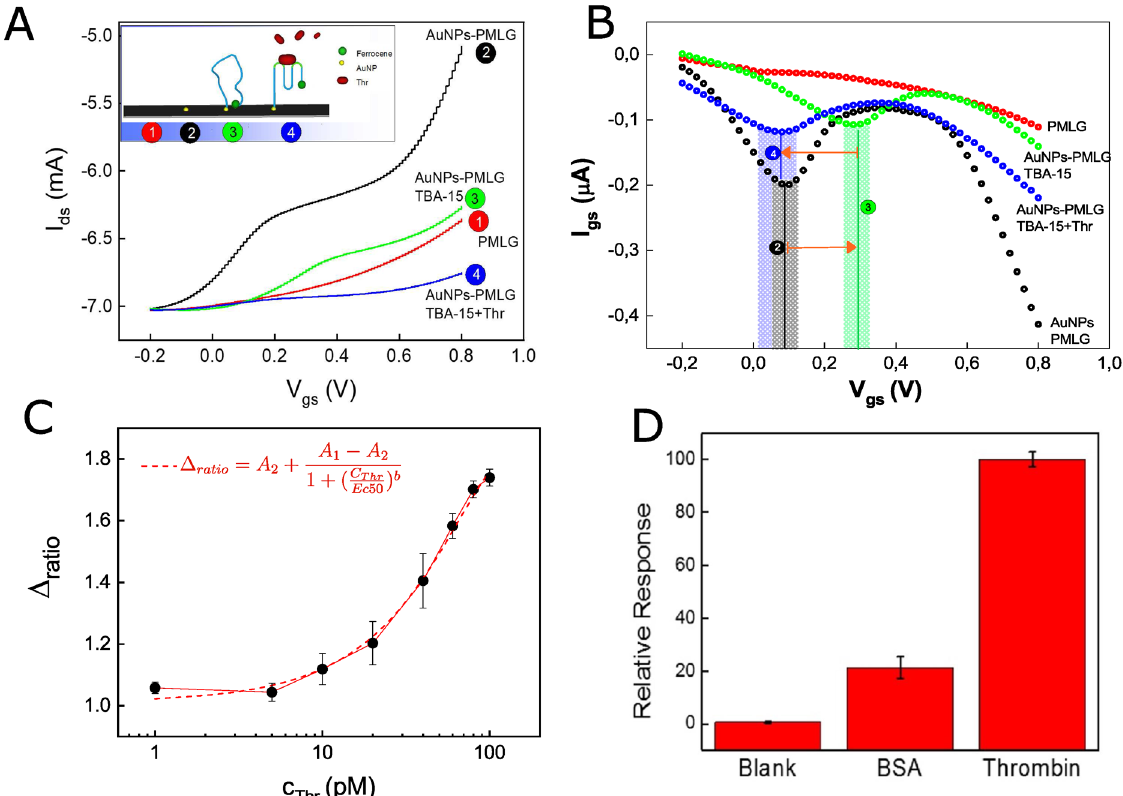
Figure 3. ( A ) comparison between typical transfer curves obtained for thrombin-incubated and non-incubated gate electrodes (TBA15-functionalized AuNPs-PMLG, blue line; unfolded TBA15-functionalized AuNPs- PMLG, concentration 1 μM -green line; bare PMLG, red line, and AuNPs-PMLG, black line. In the inset: proposed detection method) and ( B ) related gate currents. Relative peaks are indicated with (2) for the AuNPs- PMLG, (3) for TBA15-functionalized AuNPs-PMLG and (4) for TBA15-functonalized AuNPs-PMLG gate electrode; ( C ) typical device response to different concentrations of thrombin ( C Thr ) described by introducing the (cid:31) ratio parameter; ( D ) selectivity test: the signal recorded in the presence of higher concentration of BSA (1 mM) is compared with the one obtained in presence of very low thrombin concentration (100